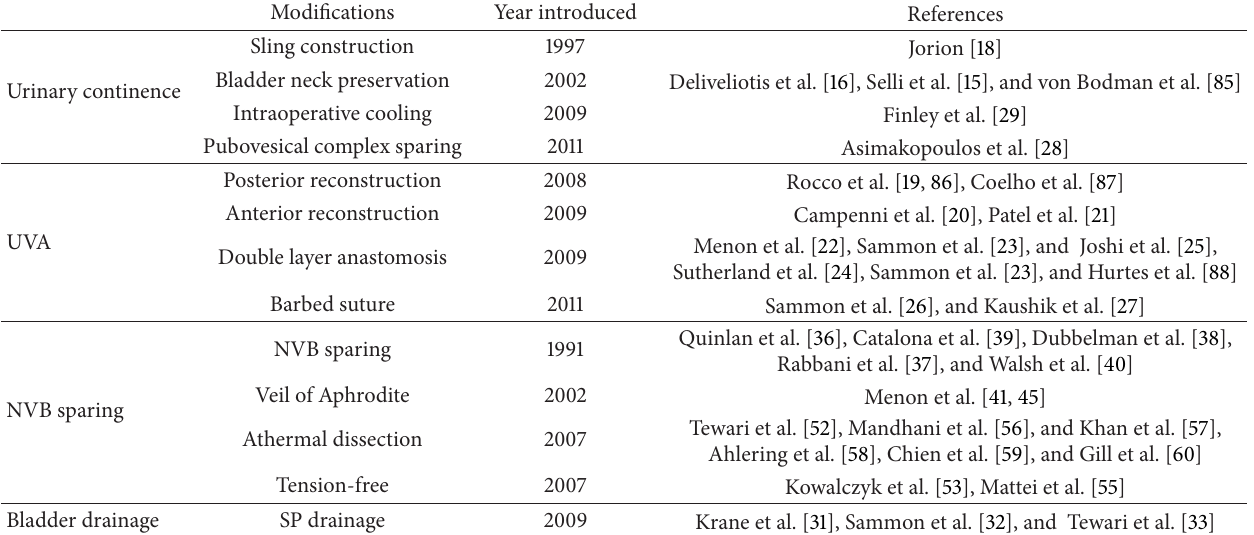
Table 1: Modifications to